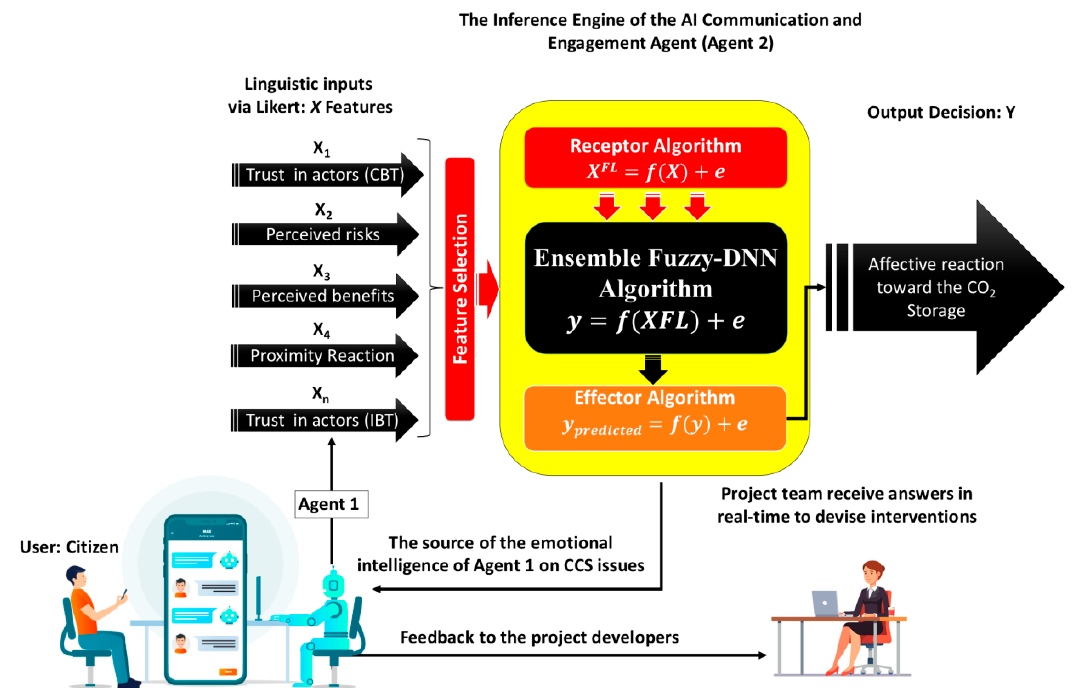
Figure 2. The block architecture of the proposed AI-powered communication and engagement agent for an energy project. In the illustration, CO 2 capture and storage (CCS) is used as a case. In real life, the system will be implemented as a chatbot. As a real-time agent, it will offer 24/7 services to the citizens faced with the energy project in question. As shown in the block architecture,